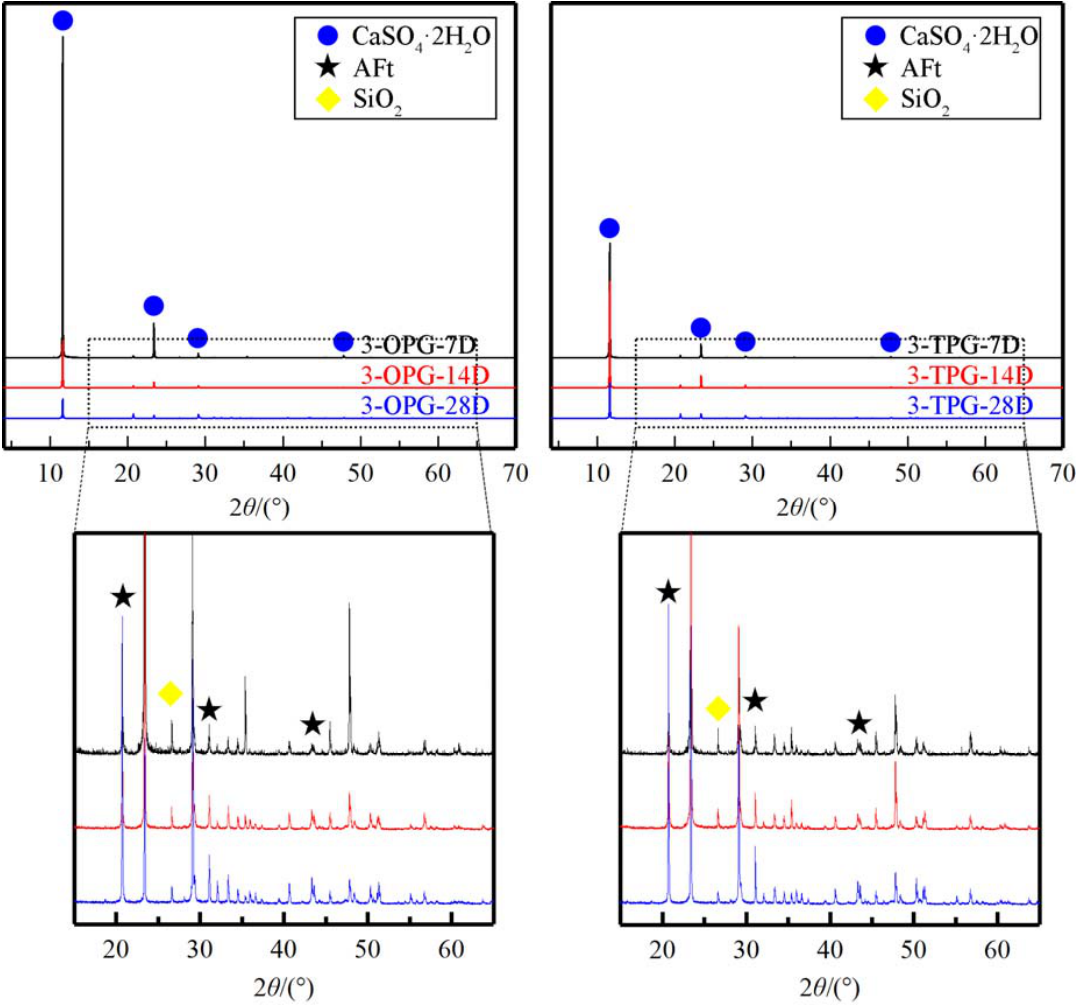
Figure 12. XRD patterns of OCPB and TCPB.